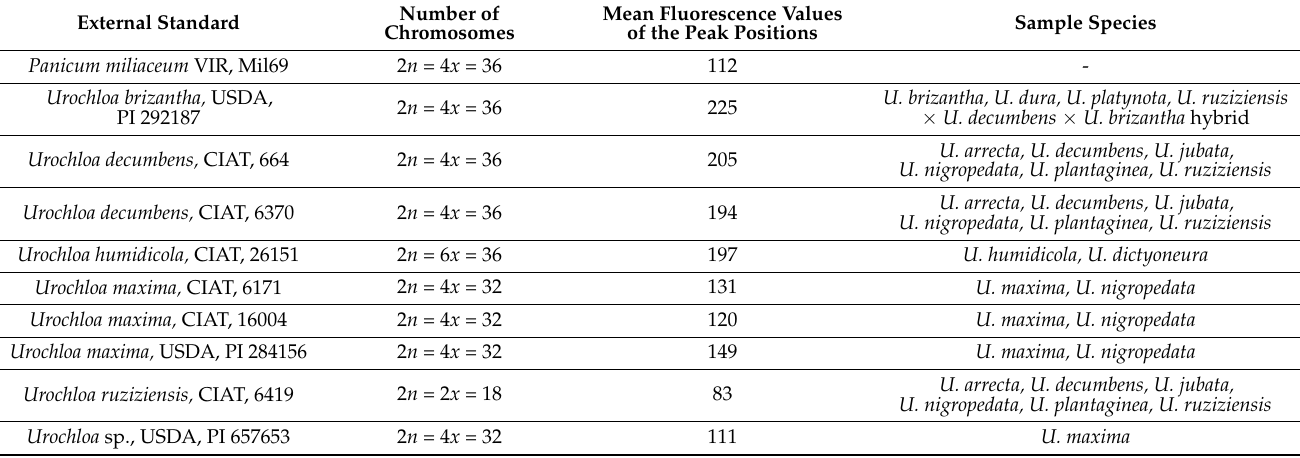
Table 1. External standards used for flow cytometry analysis of Urochloa germplasm collection. Chromosome numbers were counted